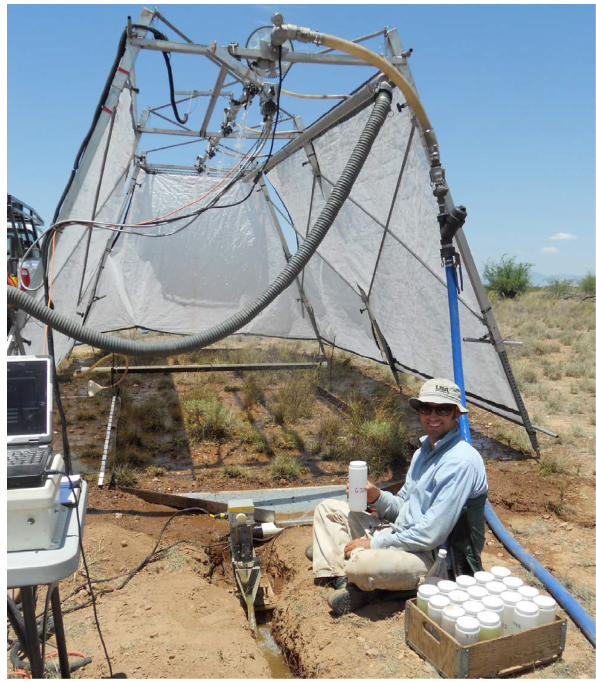
Figure 1. Walnut Gulch Rainfall